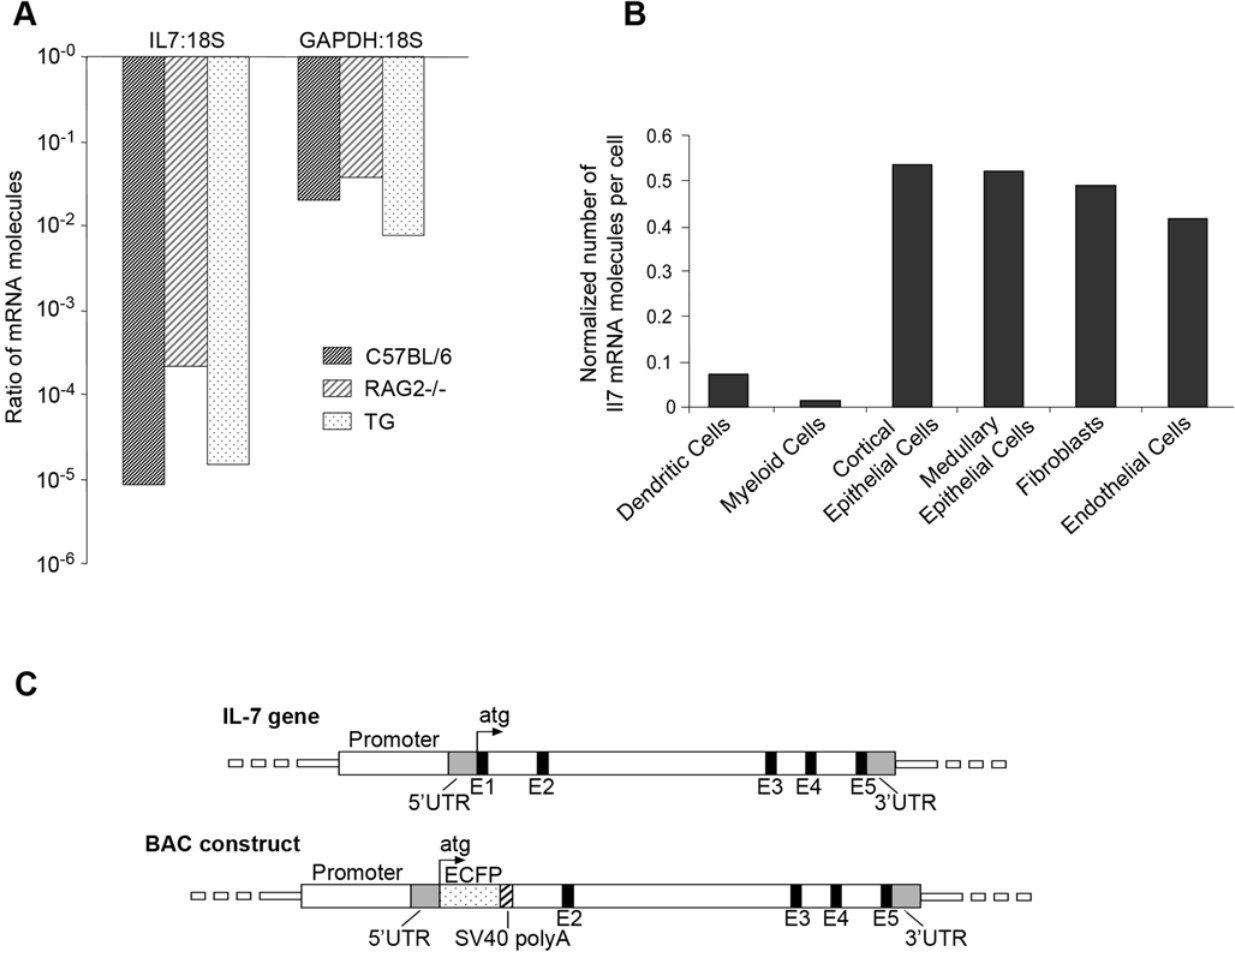
Figure 1. Il7 mRNA expression in different mouse strains and in thymic stromal cell subtypes. A. Thymi from C57BL/6, Rag2 2 / 2 and transgenic (TG) mice expressing IL-7 under control of the K14 promoter were analyzed for levels of Il7 and Gapdh expression normalized to 18 s . Wild type and even the transgenic mice expressed very low relative levels of Il7 mRNA, while the Rag2 2 / 2 showed somewhat more, presumably because the thymus is enriched for stromal cells. Gapdh was expressed at a comparable level among all the strains. Data are the mean of three mice, no standard deviations are shown because ratios were used in the calculations. B. Quantification of Il7 mRNA molecules in thymic stromal cells. Stromal cell subsets were sorted using specific surface markers (Table 1B). RNA was extracted and absolute real time PCR quantification was performed. Il7 mRNA expression was normalized to Hprt mRNA expression for each subset. The data shown is representative of at least 2 separations for each subset. C. BAC construct for the IL7promECFP transgenic mouse. The wild type murine Il7 gene is represented in the upper part of the figure. A BAC containing the mouse Il7 gene (lower part of the figure) was modified and used to create the transgenic mouse. The exon 1 sequence, encoding the signal peptide was replaced with the Ecfp cDNA sequence starting after the ATG start site. The production of ECFP would thus be driven by the Il7 promoter in IL-7 producing cells. Elimination of the signal peptide was intended to cause ECFP to accumulate inside IL-7 producing cells, enhancing